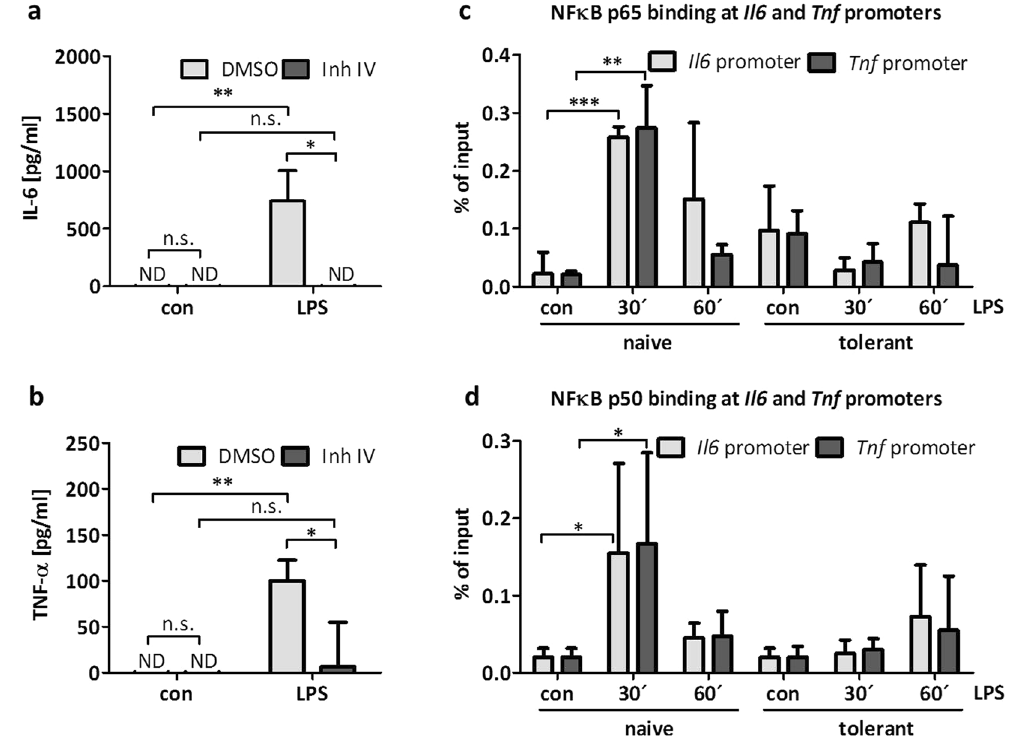
Figure 3. NF κ B p65 and p50 binding to cytokine promoters is reduced in tolerant BMMCs. BMMCs were treated with the IKK- β inhibitor Inh IV (3 µ M) for 1 h and then stimulated with LPS (300 ng/ml) for 4 h to measure IL-6 ( a ) and TNF- α ( b ) protein production. Data show mean ± SD from n = 3 independent experiments. Student’s t -Test was performed to calculate the p-values. To induce ET, BMMCs were incubated with LPS (300 ng/ml) for 24 h. Cells were left unstimulated (con) or stimulated with LPS (1 µ g/ml) for 30 min and 60 min and ChIP analysis was performed to measure NF κ B p65 ( c ) and NF κ B p50 ( d ) binding to Il6 and Tnf promoters. Data show mean ± SD from three independent experiments. Two-sided ANOVA with Tukey HSD post-hoc test was performed to calculate the p-values. Multiple testing p-values were corrected by FDR. * p < 0.05, ** p < 0.01, *** p <